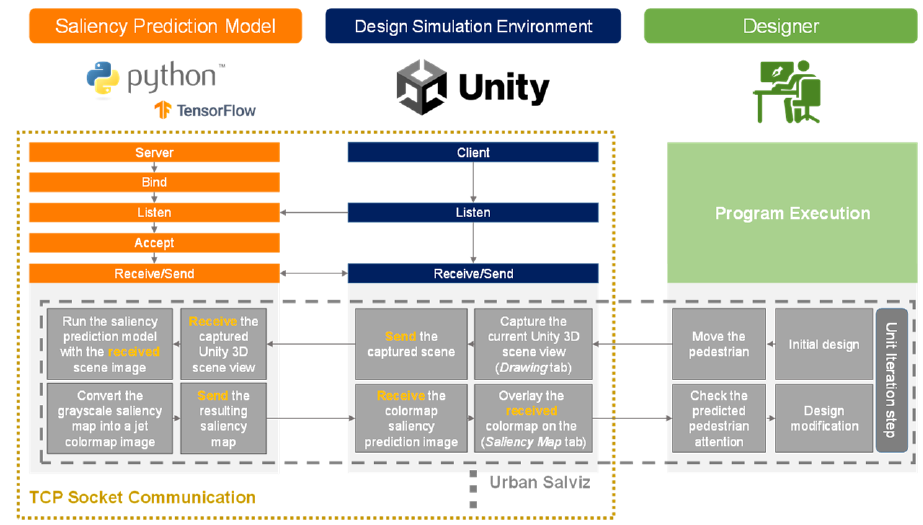
Figure 7. Implementation architecture of Urban Salviz. The design simulation part is based on Unity, and the saliency prediction is based on Python TensorFlow. Both parts continuously send and transfer the targets and resulting images to provide seamless iterative feedback.